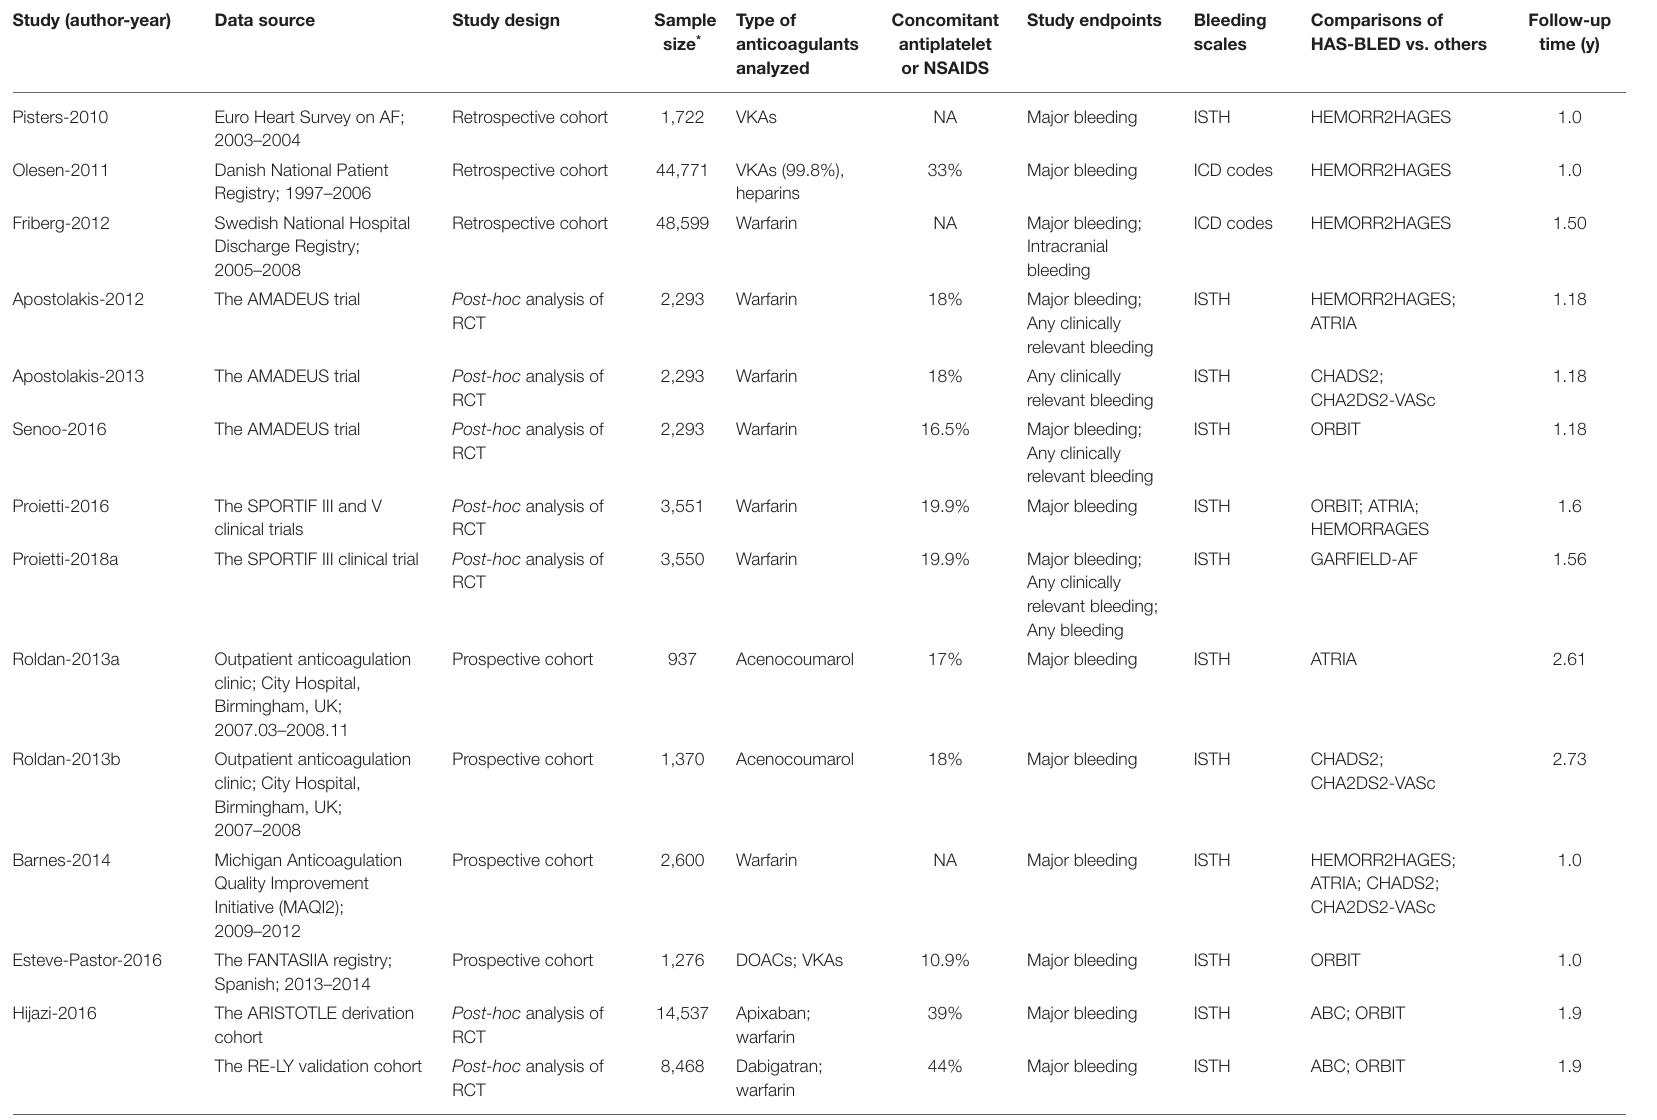
TABLE 1 | Baseline characteristics of patient of the included